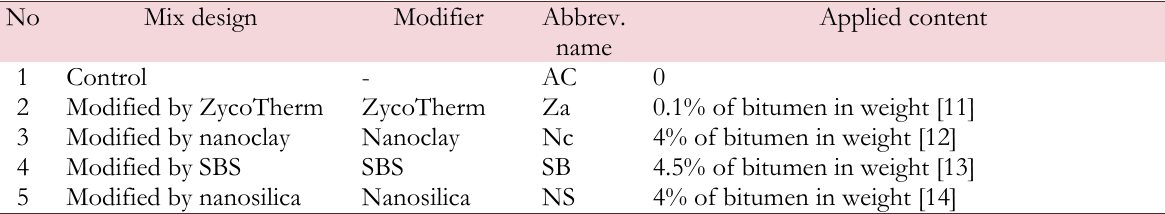
Table 3: Name of specimens and percent of each material for optimum bitumen